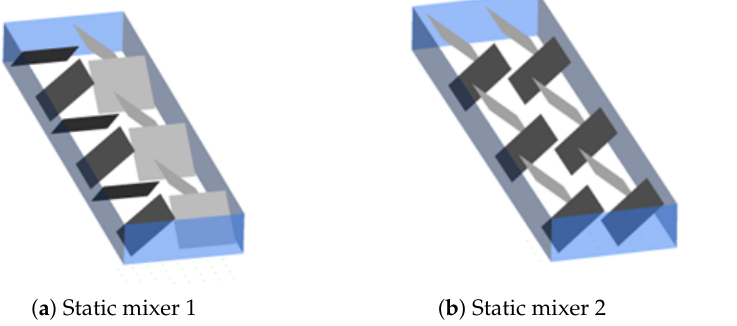
Figure 3. Arrangement of static mixers: ( a ): The arrangement of static mixer 1. ( b ): The arrangement of static mixer